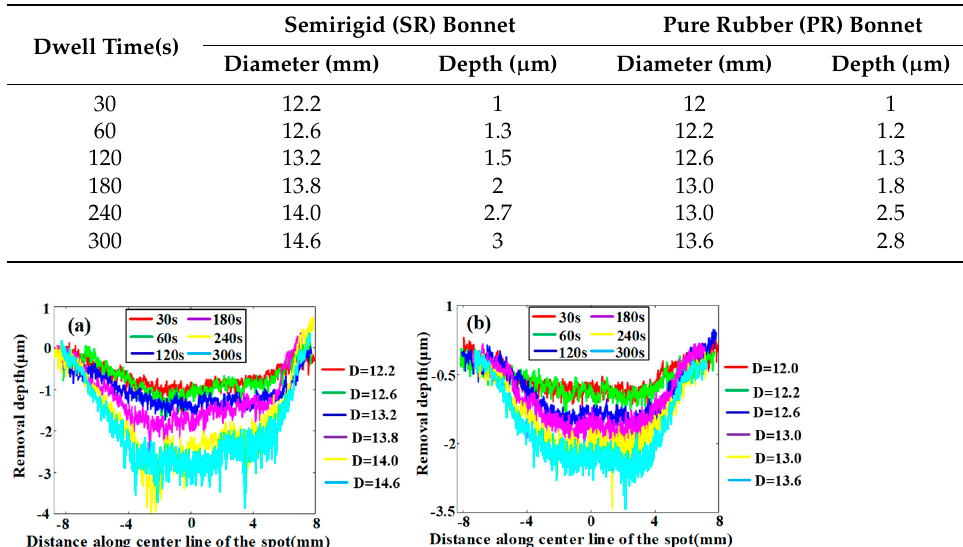
Table 4. Section size of polishing point.